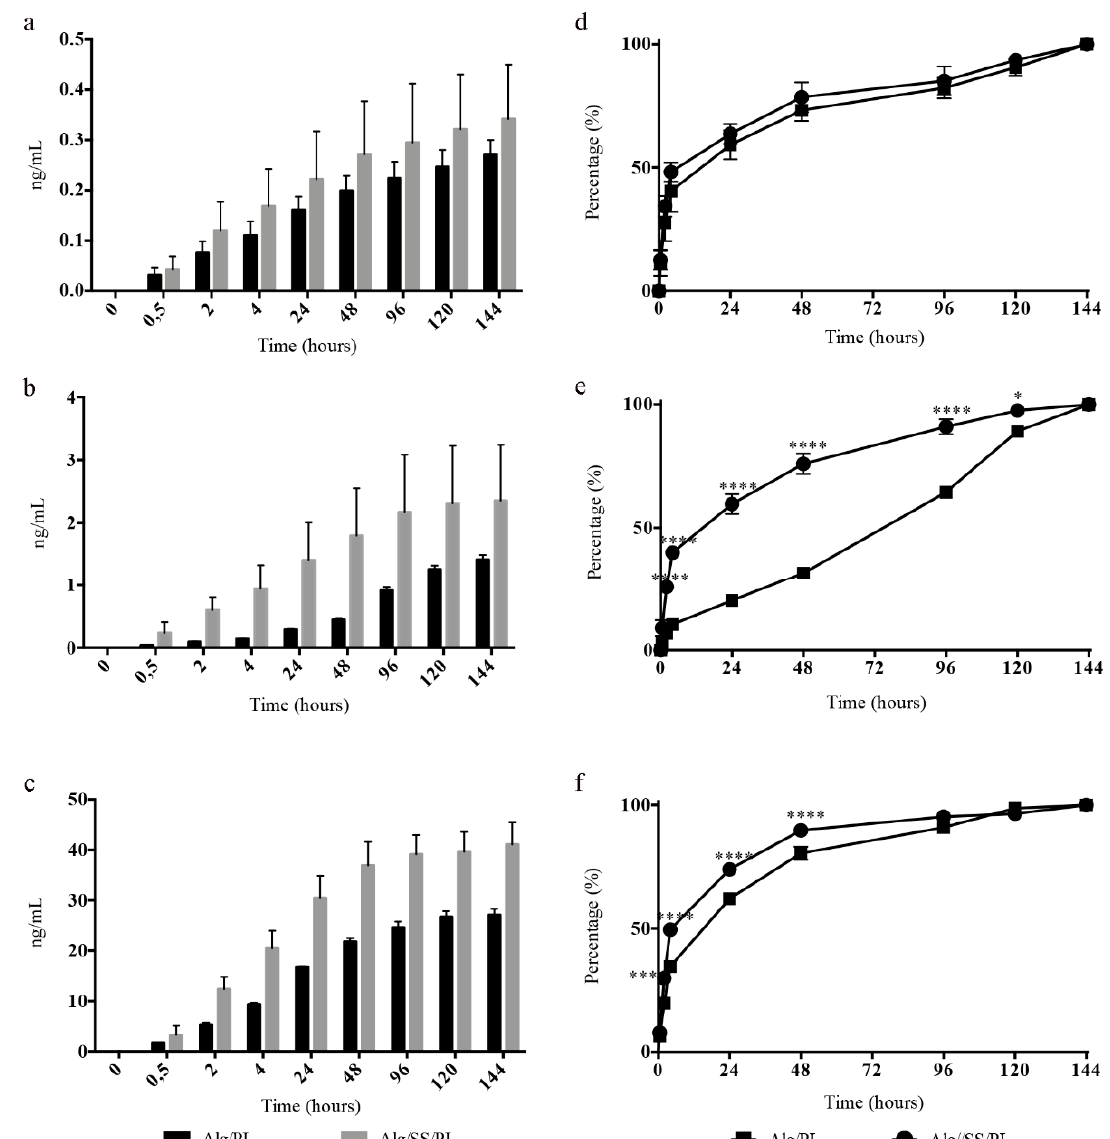
Figure 3. Growth factors release analysis. Release of growth factors from Alg/PL and Alg/SS/PL biomembranes after incubation in physiological solution at 37 °C and 5% CO 2 . The amounts of Vascular Endothelial Growth Factor (VEGF) ( a ), Platelet-derived Growth Factor-BB (PDGF-BB) ( b ) and Transforming Growth Factor Beta 1 (TGF- β 1) ( c ) released in the incubation medium at different time points were determined by ELISA assay. The curves represent the release during time of the three different factors expressed as percentage of the maximum release: VEGF ( d ), PDGF-BB ( e ), TGF- β 1 ( f ), **** p < 0.0001, *** p < 0.001, * p < 0.05.